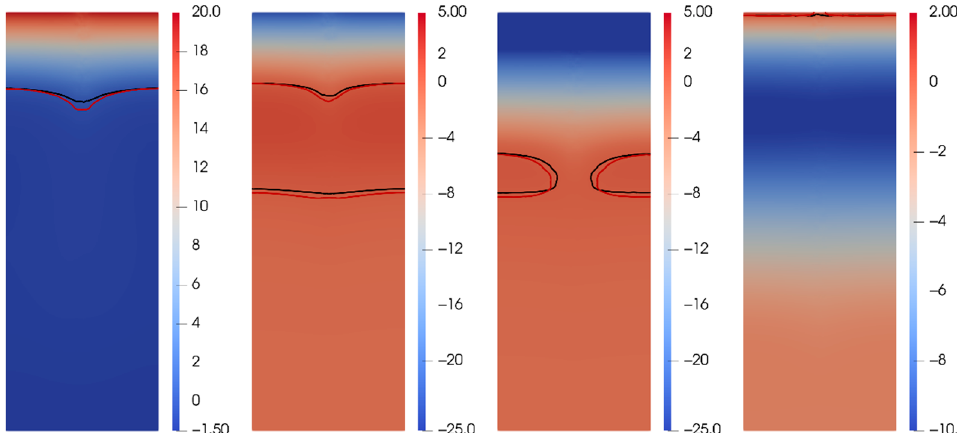
Figure 6. Temperature distribution for different time layers ( t = 50, 200, 250, 365 days) in case of steel fiber reinforcement. From left to right. (red line is isocline of zero for structure locations, black is isocline of zero for random locations).